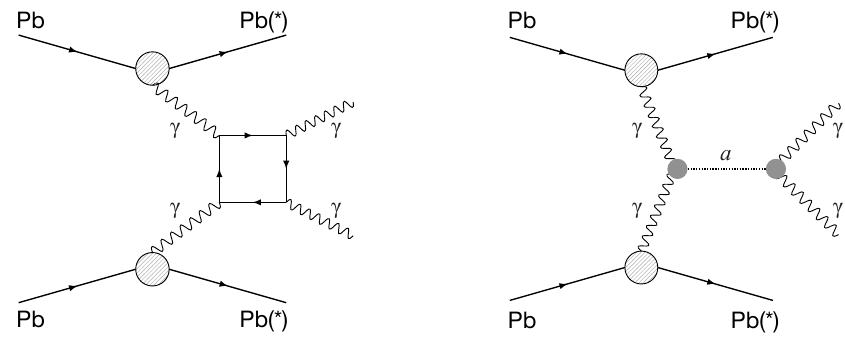
Figure 1 . Schematic diagrams of (left) SM LbyL scattering and (right) axion-like particle produc- tion in Pb+Pb UPC. A potential electromagnetic excitation of the outgoing Pb ions is denoted by ( ∗ )